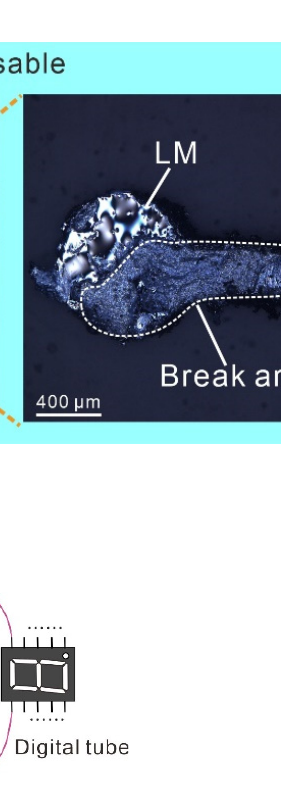
Figure A5. Schematic of the circuit connection of seven MCSMs controlling a digital tube.